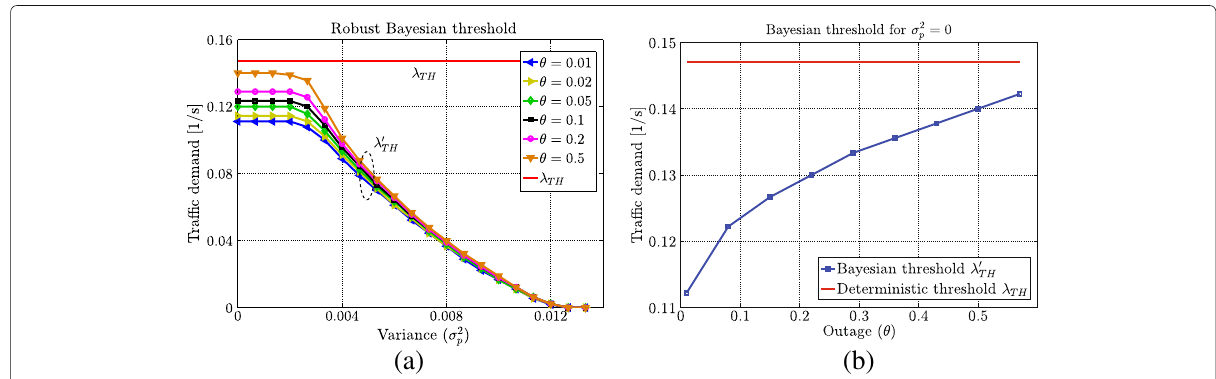
Fig. 11 Example of on/off switching robust Bayesian threshold for different values of outage probability θ and variance σ 2 p . For comparison purposes, the deterministic threshold λ TH is also depicted. a Bayesian threshold as a function of the variance σ 2 p for different outages. b Bayesian threshold as a function of the outage probability for σ 2 p =